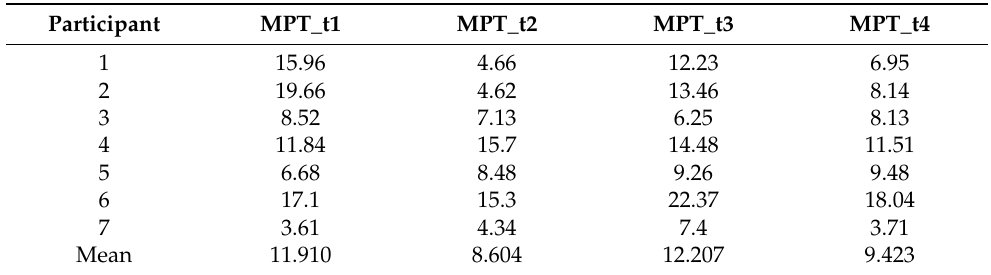
Table 8. MPT (seconds) individual and mean measurements at four assessment time points.